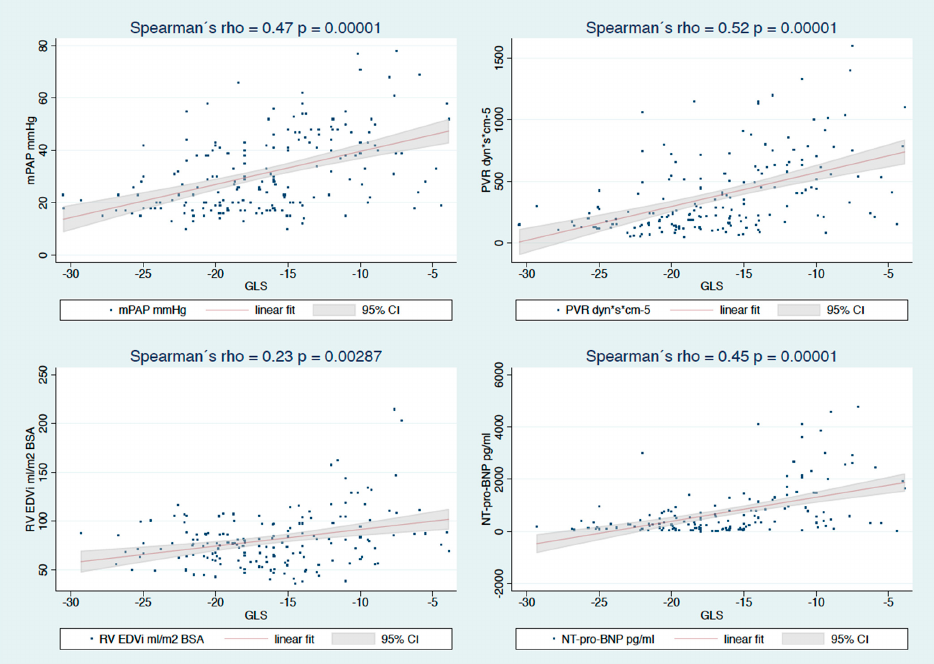
Figure 5. Correlations of GLS with mPAP, mean arterial pressure of the pulmonary artery, PVR, pulmonary vascular resistance, RV EDVi, right ventricular end-diastolic volume indexed for body surface area and NT-pro BNP.